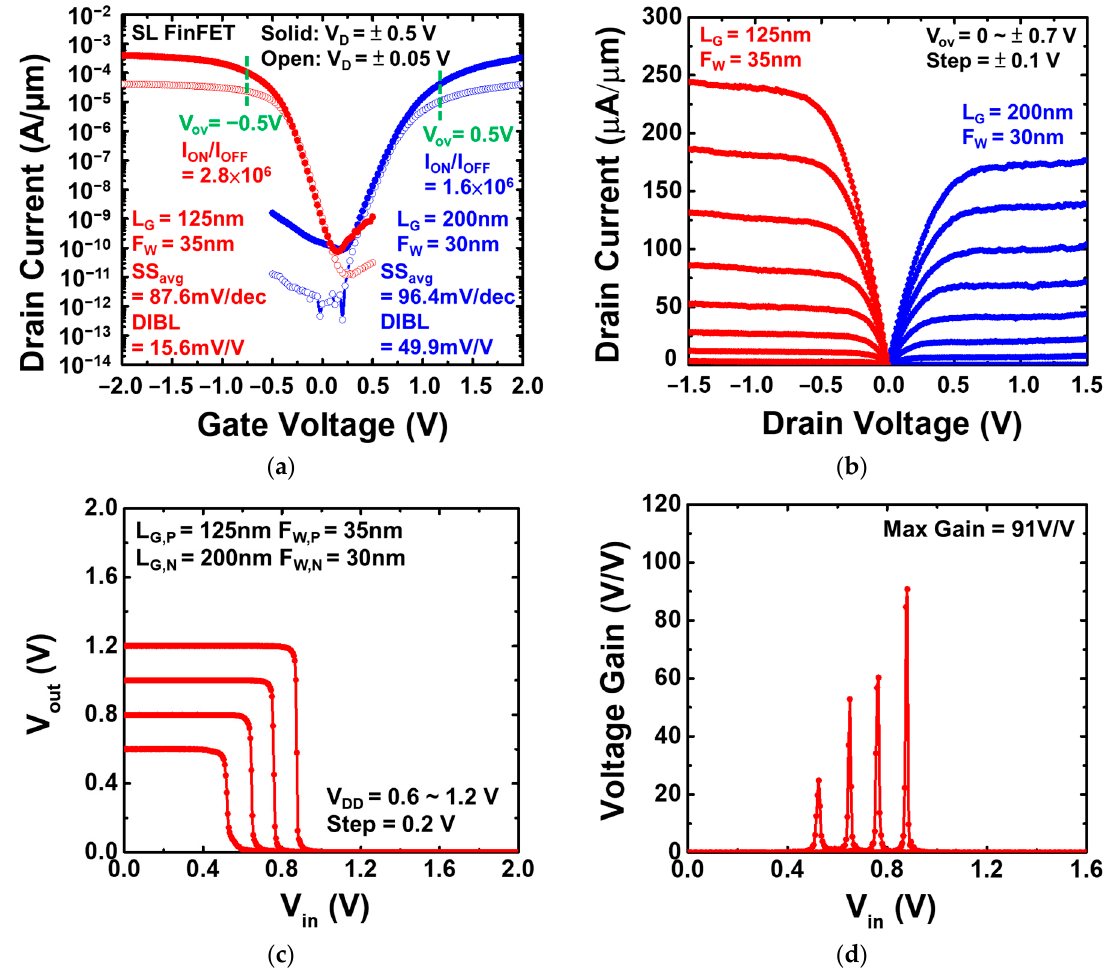
Figure 11. ( a ) I D -V G and ( b ) I D -V D characteristics of the Si 0.8 Ge 0.2 /Si SL FinFET CMOS inverter. ( c ) VTC and ( d ) gain of the Si 0.8 Ge 0.2 /Si SL FinFET CMOS inverters with the V DD ranging from 0.6 to 1.2 V.